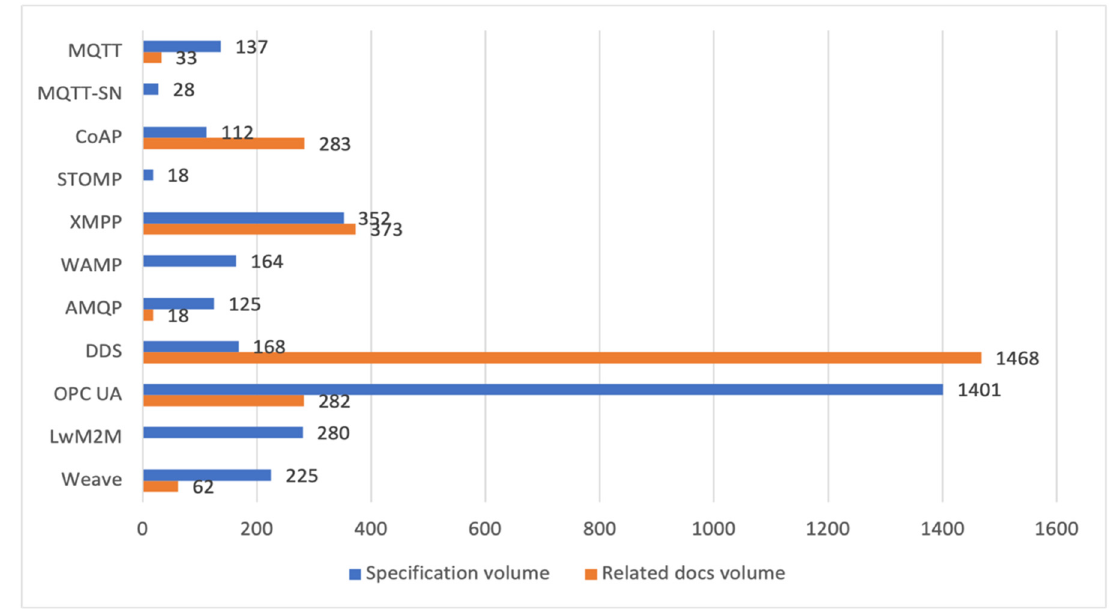
Figure 2. Volume of the protocol documentation in the number of pages.